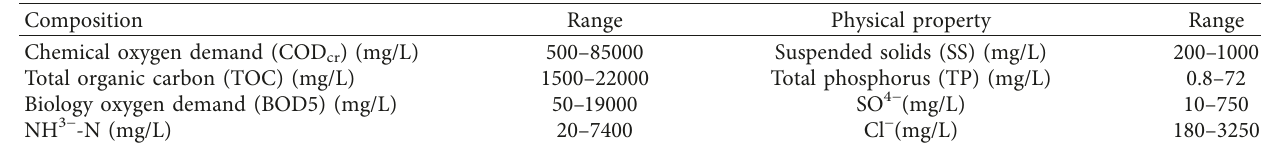
Table 2: Composition of